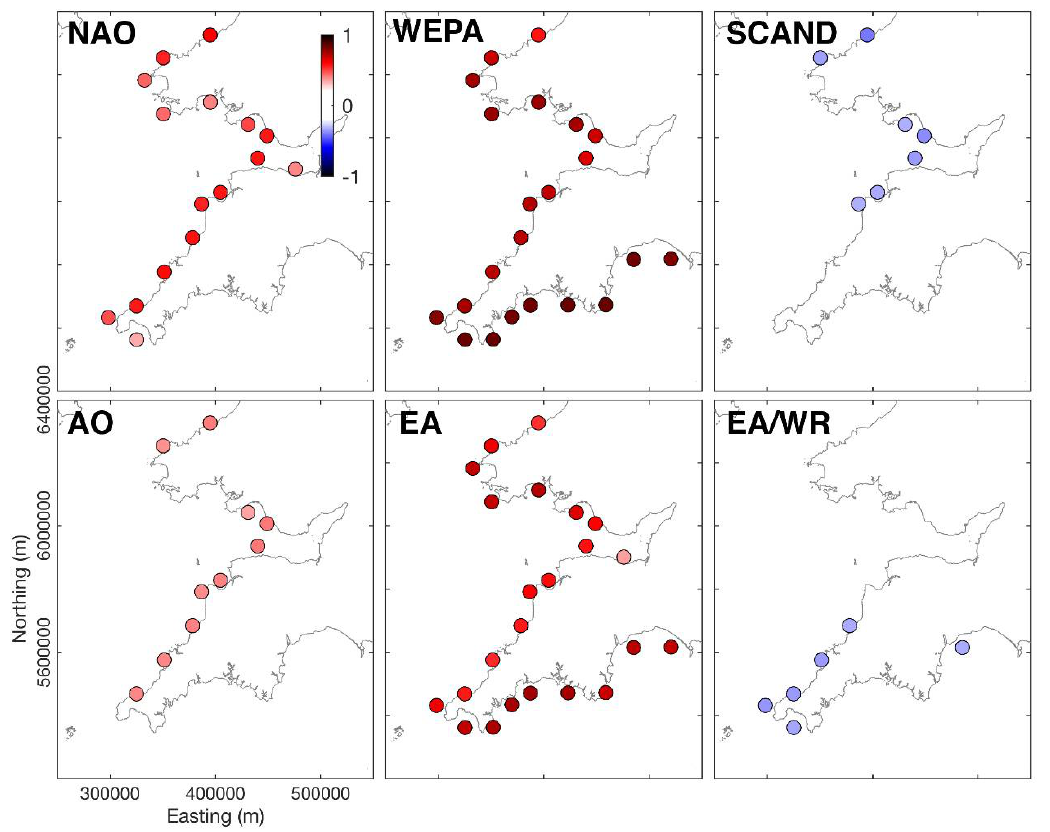
Figure 1. Shows the correlation (colour bar inset) between winter averaged wave power and the six leading climate indices in the northeast Atlantic (NEA) at coastal nodes around the southwest UK. This plot is a truncated version of the results shown in Scott et al. [25].